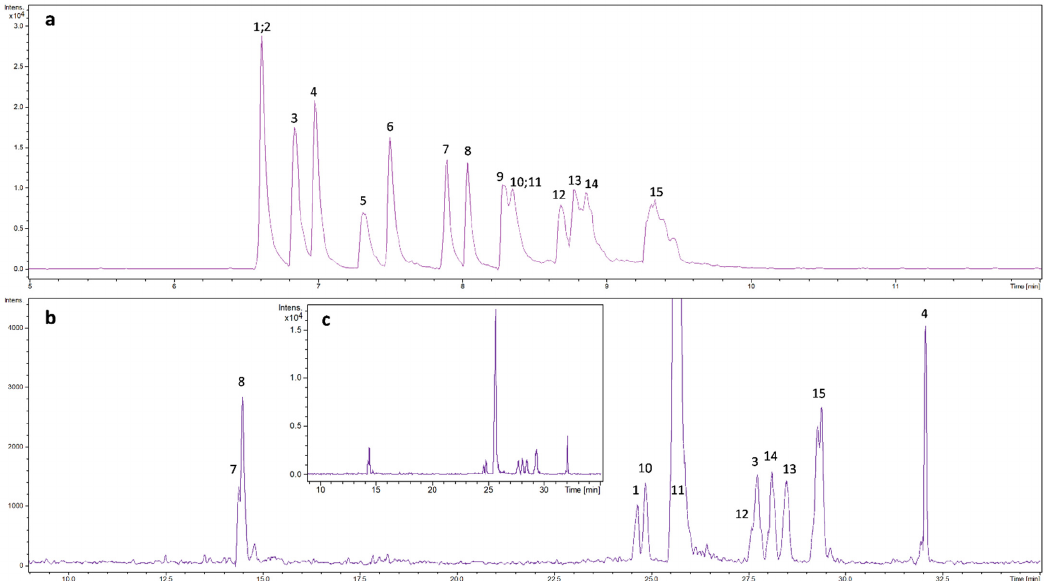
Figure 2. CZE-MS electropherograms obtained with ( a ) 0.5 M NH 4 OH (pH = 11.4) and ( b ) 50 mM ammonium-acetate (pH = 7) including an inset ( c ) which represents ( b ) the electropherogram with a larger intensity scale. The number of the peaks correspond with the number assigned to the com- ponents given in Figure 1. Conditions: capillary: 90 cm × 50 µm, U = +30 kV, sample injection: 50 mbar × 4 s, MS: negative ionization mode, sheath liquid: IPA:water = 1:1, sheath liquid flow: 6 µL/min, nebulizer pressure: 0.8 bar, drying temperature: 200 °C, spectra rate: 2 Hz. Sample: 3.833 mg/L 3,4-dimethoxycinnamic acid (1), 0.209 mg/L chrysin (2), 11.63 mg/L 4-(dimethylamino)benzoic acid (3), 17.44 mg/L cinnamic acid (4), 49.87 mg/L benzoic acid (5), 22.89 mg/L salicylic acid (6), 1.765